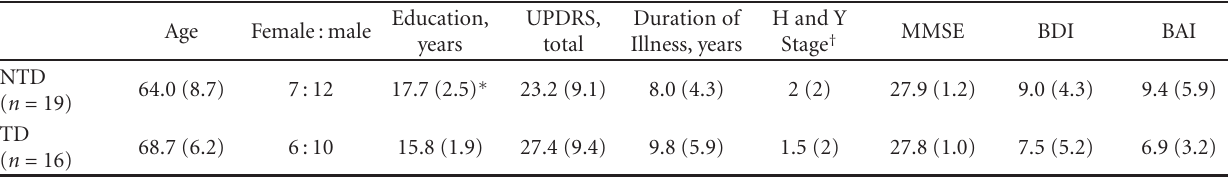
Table 1: Participant characteristics.